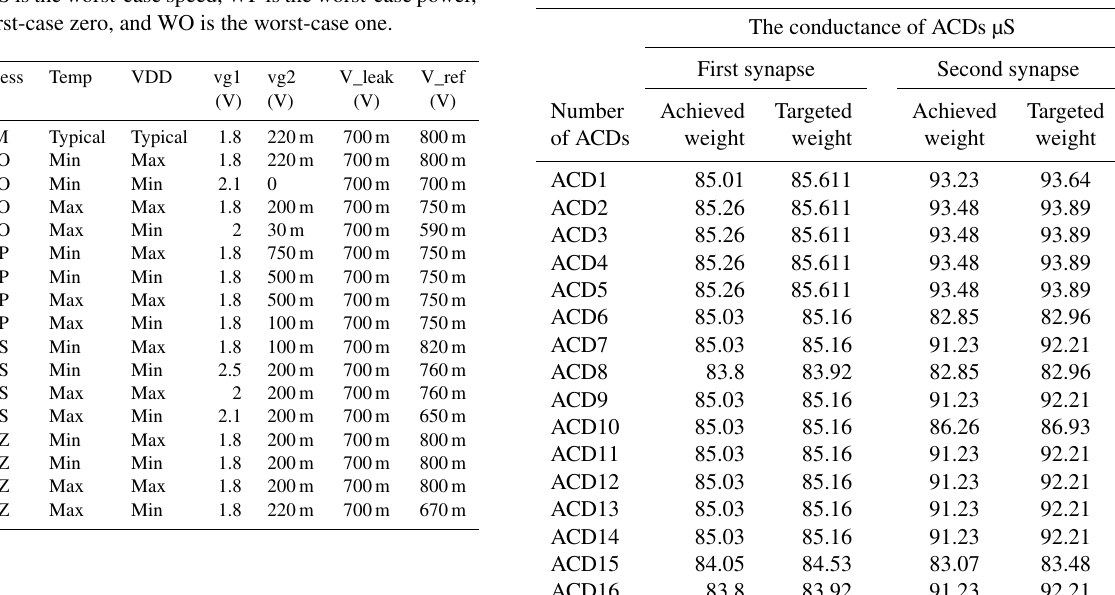
Table 5. The achieved and targeted values of the synapses weight when the variables V LEAK , V RFR , vg1, and vg2 of the second layer are fixed to 700mV, 800mV, 1.8V, and 220mV,